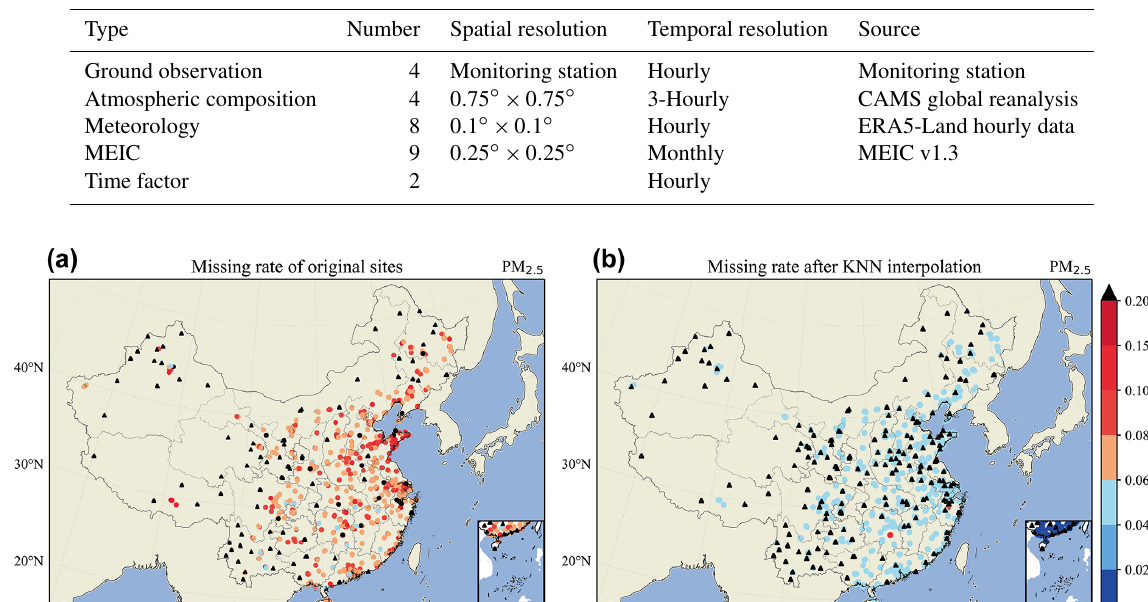
Table 1. Summary of empirical input variables.